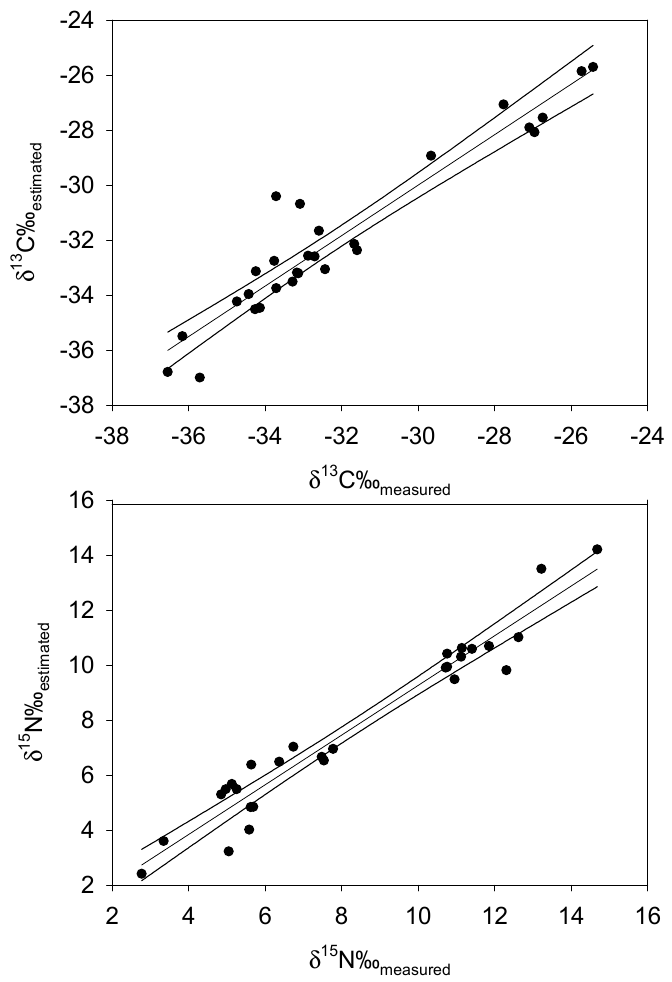
Figure 4. Relationship between isotopic fingerprint (carbon and nitrogen) of pooled zooplankton samples belonging to ≥ 450 µm and ≥ 850 µm size fractions determined by instrumental analysis (measured) and reconstructed values (estimated) following Equation (2).